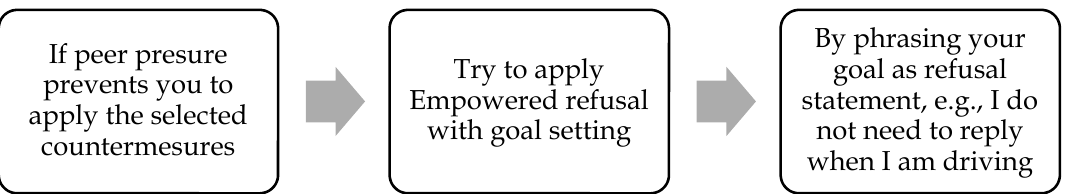
Figure 1. Sample of empowered refusal and self-talk booklet (Booklet 4).